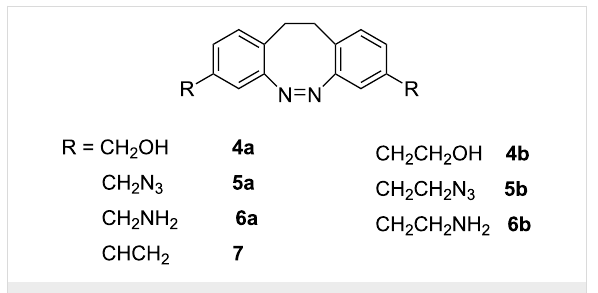
Figure 2: Synthesized target diazocines 4–7 for applications in responsive